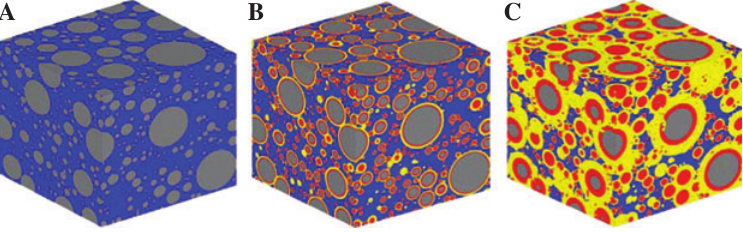
Figure 1 Three different hydration stages of the model cement paste with water/cement = 0.3 based on HYMOSTRUC3D model [28, 34] : (A) a = 0 % ; (B) a = 25 % ; (C) a = 65 %